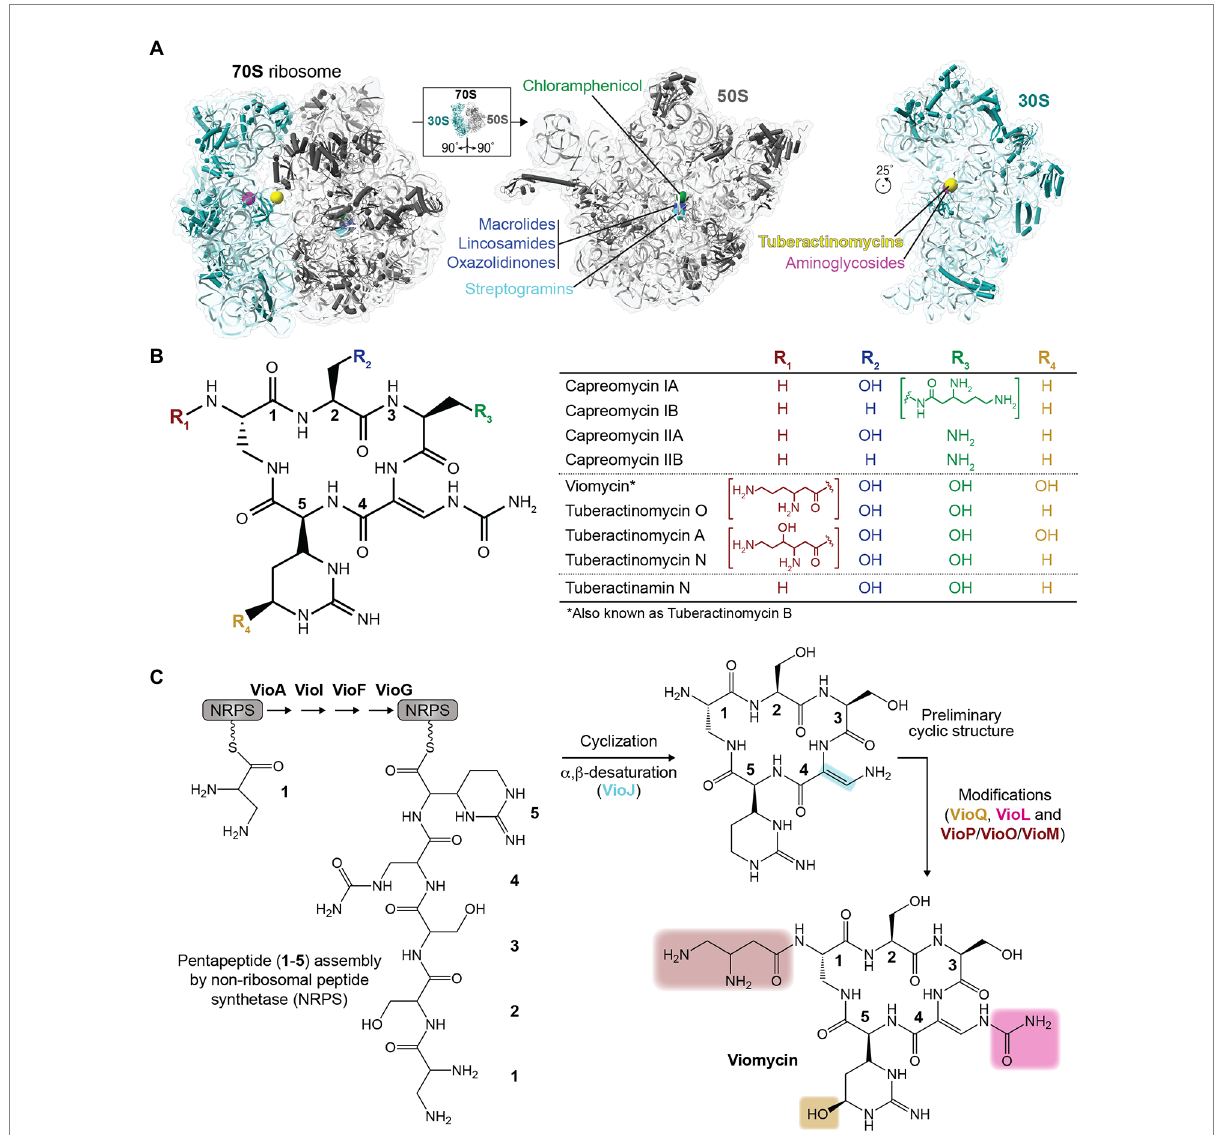
FIGURE 1 Ribosome-targeting antibiotics and chemical structures of the tuberactinomycins. (A) Sites of action of select clinically relevant ribosome- targeting antibiotics are shown on the structure of the intact Escherichia coli 70S ribosome ( left ) and individual subunits (right) rotated as indicated to show their subunit interfaces (PDB code 6LKQ). The indicated antibiotics target the 50S (large) subunit at the peptidyl transferase center and nascent peptide exit tunnel (chloramphenicol, lincosamides, oxazolidinones, streptogramins, and macrolides), or the 30S (small) subunit decoding center and nearby inter-subunit interface (aminoglycosides and tuberactinomycins). (B) Chemical structures of the tuberactinomycin antibiotics shown as the common pentapeptide core scaffold ( left ) and unique substituents at four variable positions (R1 to R4; as indicated in the table on the right ). (C) Overview of the process of tuberactinomycin biosynthesis (shown for viomycin), including non-ribosomal peptide synthetase (NRPS) assembly of the pentapeptide and subsequent modification